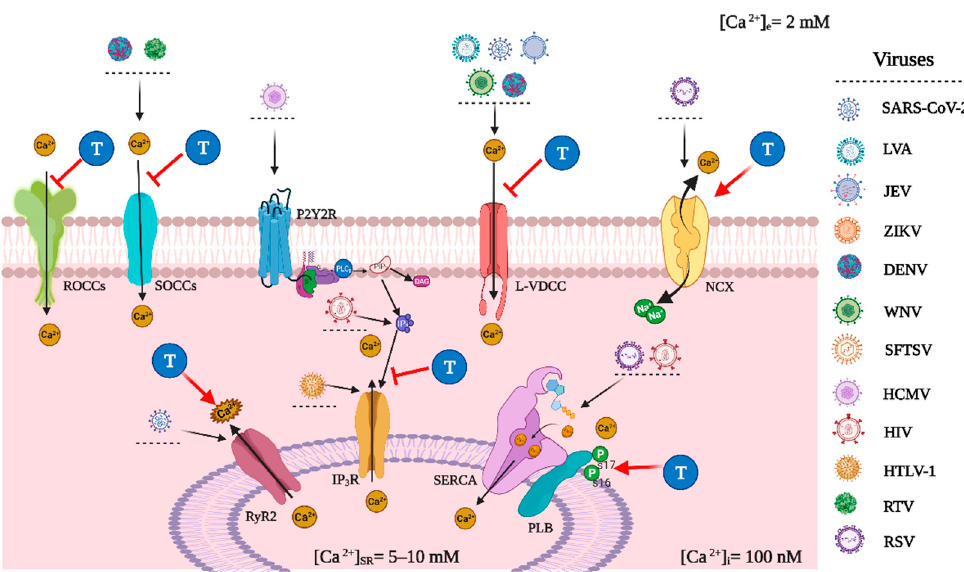
Figure 2. Viral hijacking of Ca 2+ handling proteins and testosterone modulation. Schematic representation of various stages of the viral cycle targeting the Ca 2+ apparatus in a host cell. Testosterone (T) can mitigate the dysfunction of Ca 2+ homeostasis induced by the viral infection through the modulation of the activity and expression of various Ca 2+ handling proteins. In the plasma membrane, T can acutely inhibit receptor operated calcium channels (ROCCs) in vascular smooth muscle (VSM), T also inhibits store operated calcium channels (SOCCs) acutely in airway smooth muscle (ASM) and VSM. T administered acutely inhibits L-Type voltage operated Ca 2+ channels (L-VDCCs) in VSM and ASM, and, if chronically given, can downregulate L-VDCCs expression in cardiomyocytes. In these cells, T can upregulate the expression of the Na + /Ca 2+ exchanger (NCX). In the sarcoplasmic reticulum (SR), T can block the IP 3 receptor (IP 3 R). In cardiomyocytes, chronic exposure to T increases the phosphorylation of phospholamban (PLB) sites s16 and s17, increasing sarcoplasmic reticulum Ca 2+ ATPase (SERCA) activity, and can also increase the amplitude of Ca 2+ sparks from the ryanodine receptor (RyR), probably due to an increase in Ca 2+ content in the SR by the increased SERCA activity. Abbreviations on the figure: LVA, influenza A virus; JEV, Japanese encephalitis virus; ZIKV, Zika virus; DENV, dengue virus; WNV, West Nile virus; SFTSV, thrombocytopenia syndrome virus; HCMV, human cytomegalovirus; HIV, human immunodeficiency virus; HTLV-1, human T-cell lymphotropic virus type 1; RSV, respiratory syncytial virus; RTV, rotavirus; T, testosterone; GPCR, G-protein-coupled receptor; PLC- β , phospholipase C- β ; IP 3 , inositol1,4,5-trisphosphate; PIP, phosphatidyl inositol phosphate; DAG, diacylglycerol; b[Ca 2+ ]i, basal intracellular Ca 2+ concentration; [Ca 2+ ]SR, sarcoplasmic reticulum Ca 2+ concentration; [Ca 2+ ]e, extracellular Ca 2+ concentration.